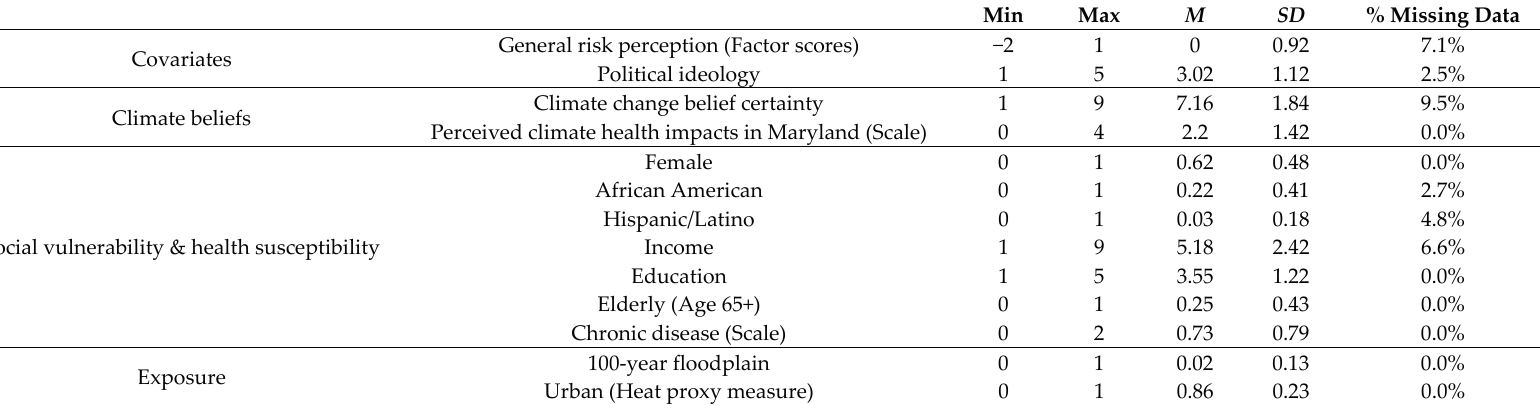
Table S2. Descriptive statistics of independent variables ( n =